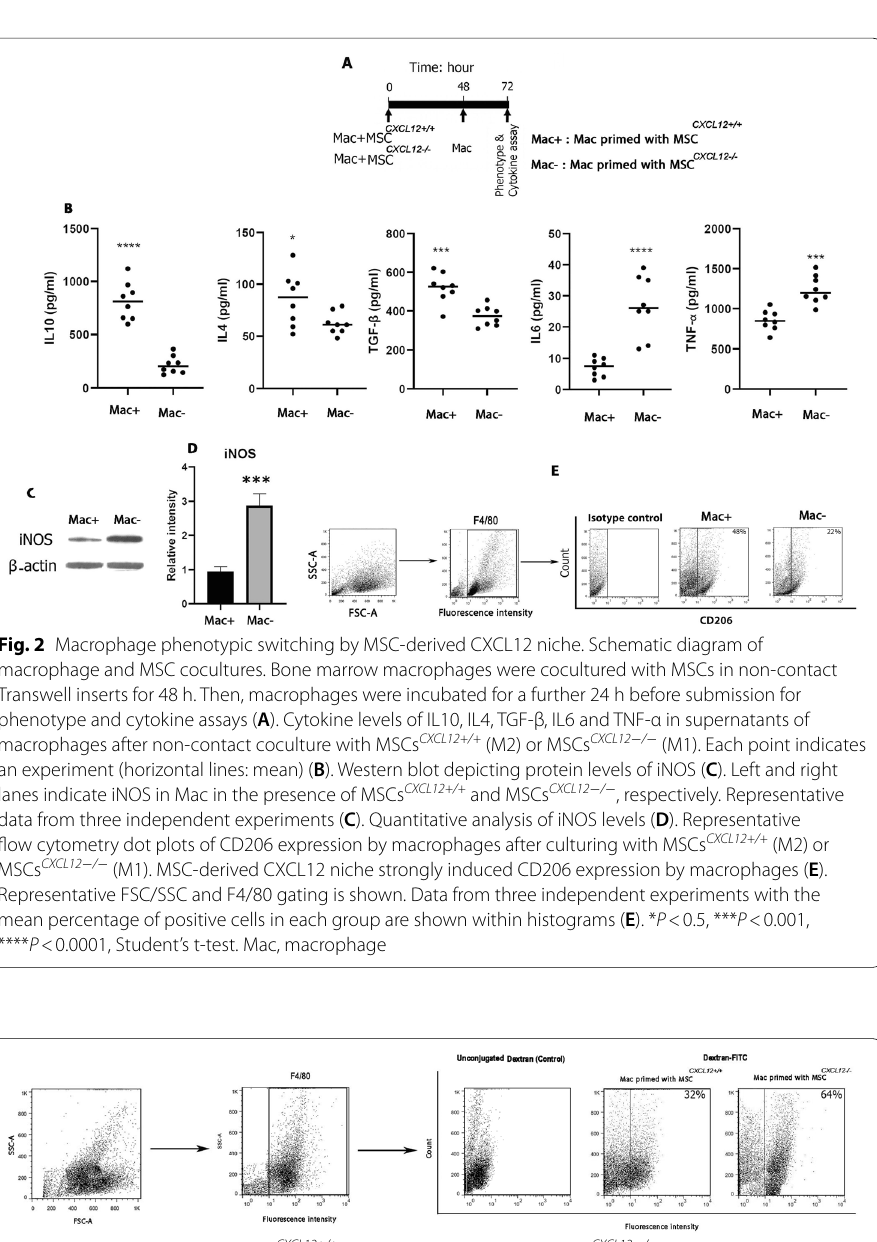
Fig. 3 Phagocytic function of MSC CXCL12+/+ ‑primed macrophages and MSC CXCL12 − / − ‑primed macrophages. Representative histogram of flow cytometry data showing higher dextran‑FITC uptake by MSC CXCL12−/− ‑primed macrophages compared with MSC CXCL12 + / + ‑primed macrophages. Representative FSC/ SSC and F4/80 gating is shown. Data from three independent experiments with the mean percentage of positive cells in each group are shown within histograms. Unconjugated dextran was used as a control. Mac,